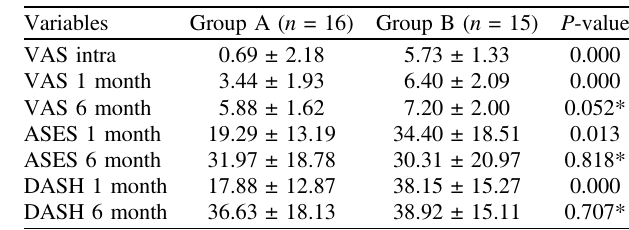
Abbreviations: VAS, visual analog scale; ASES, American shoul- der; DASH, disabilities of the arm, shoulder, and